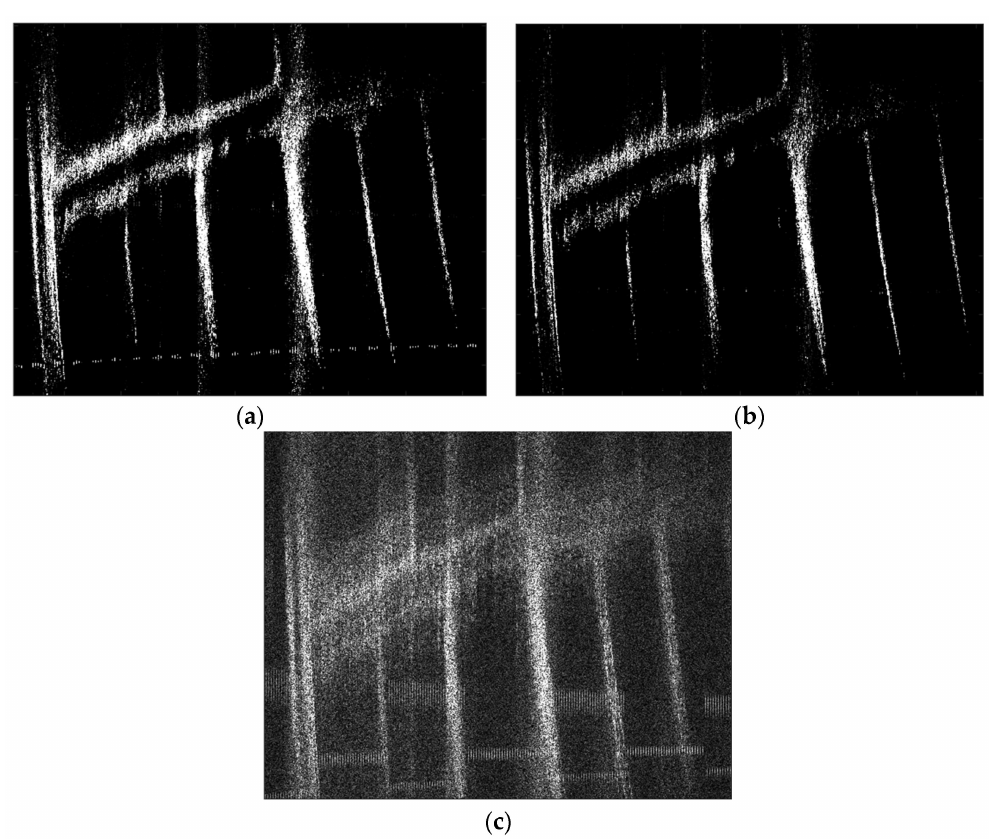
Figure 10. Imaging results of each algorithm with an undersampling rate of 0.5: ( a ) Algorithm 1, ( b ) Algorithm 2, ( c ) Direct